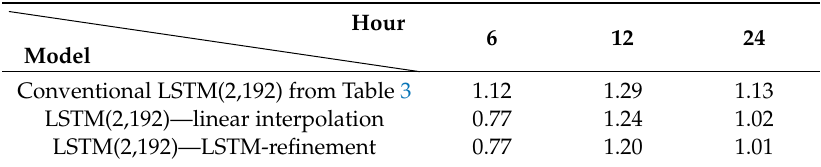
Table 4. Performance comparison of the RMSE of the LSTMs with the linear interpolation and LSTM-refinement for 6, 12, and 24 h temperature predictions.